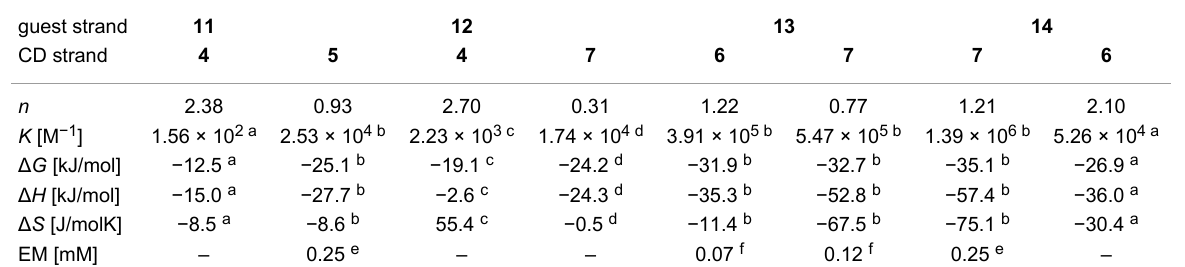
Table 3: Thermodynamic parameters of the interactions of the trivalent guest strands 11 , 12 , 13 and 14 with complementary and non-complementary divalent CD strands. guest